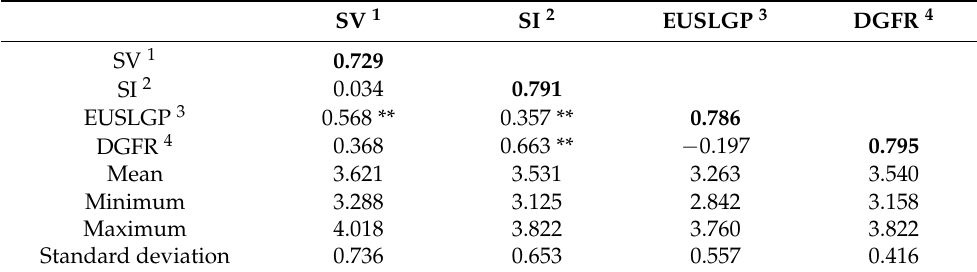
Table 1. Correlations, discriminant validity, and statistical value of variables. SV 1 SI 2 EUSLGP